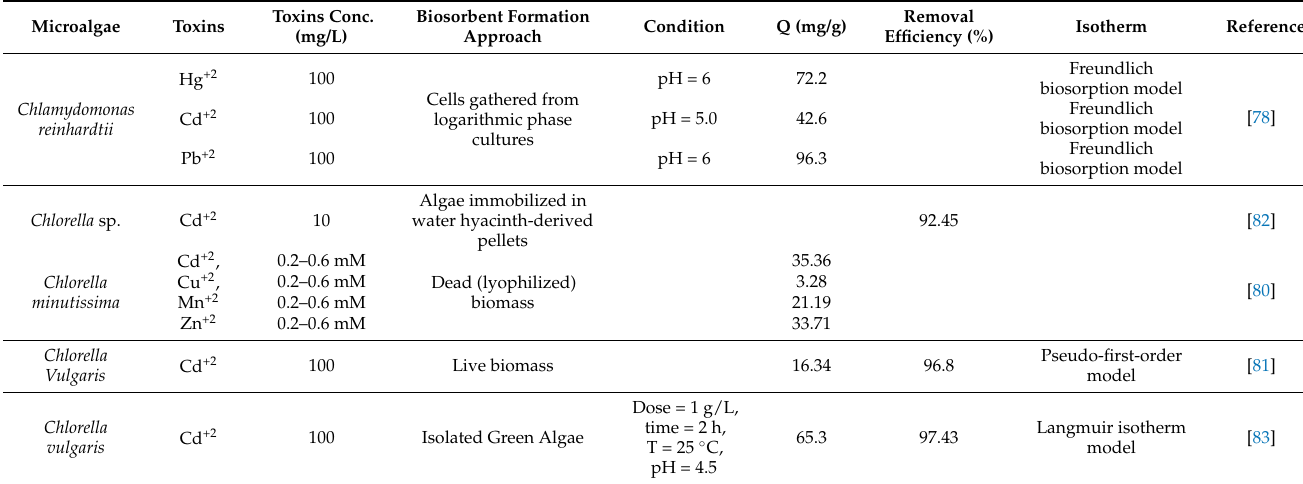
Table 4. Metallic Toxins Eradication Using